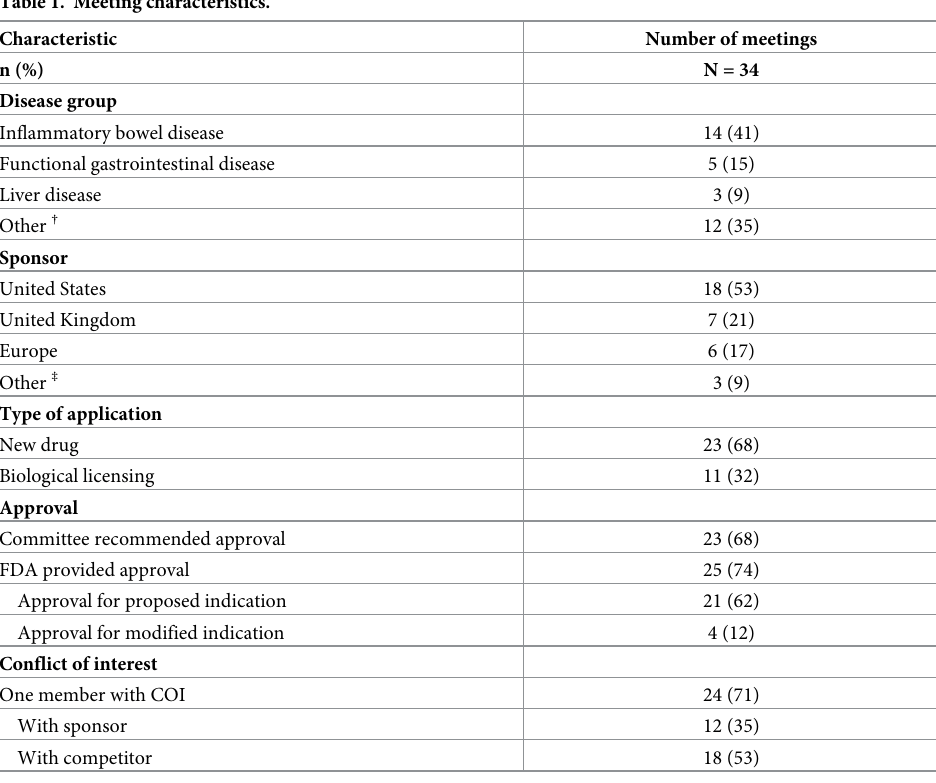
Table 1. Meeting characteristics.